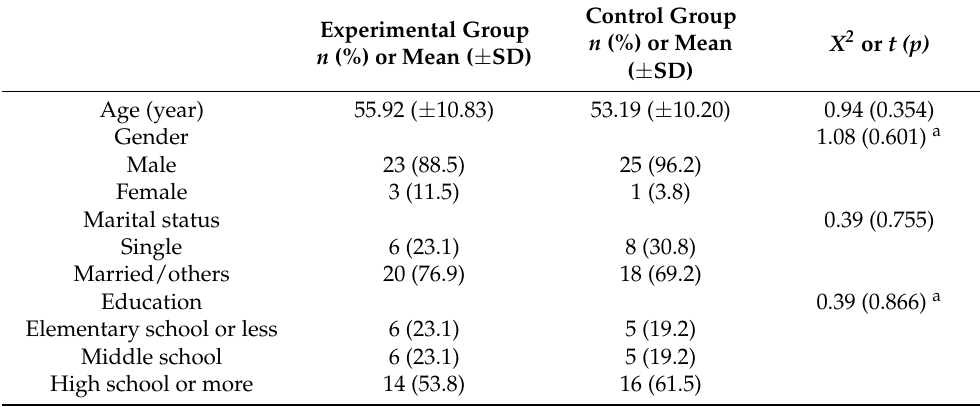
Table 2. Homogeneity of socioeconomic and health-related characteristics between experimental ( n = 26) and control ( n = 26)